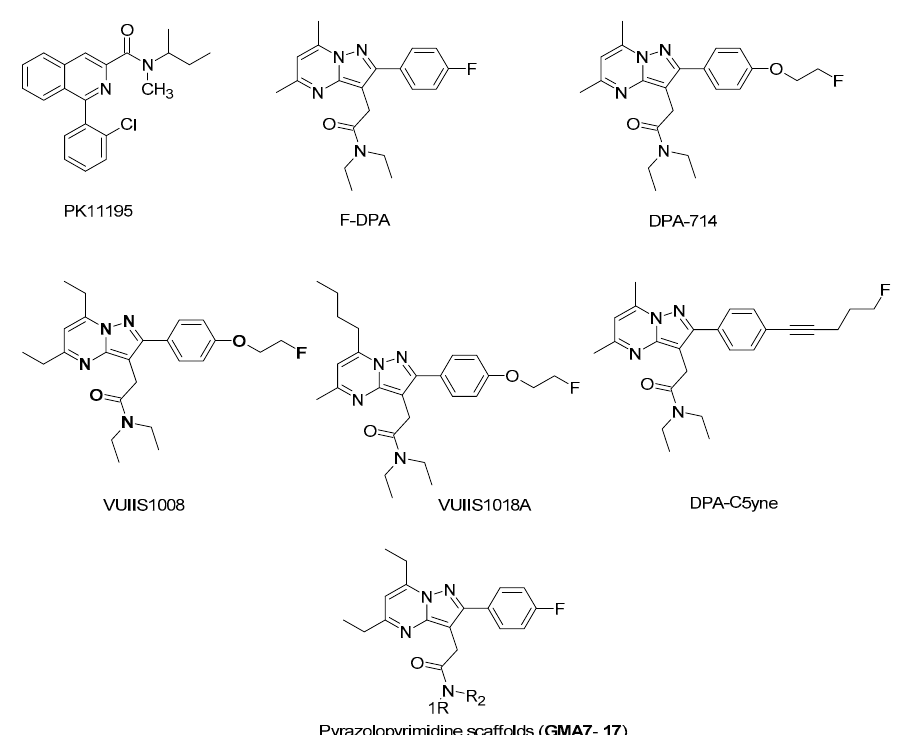
Figure 1. Selected high-affinity TSPO ligands and the synthesized pyrazolopyrimidine scaffold ( GMA 7 – 17 ).